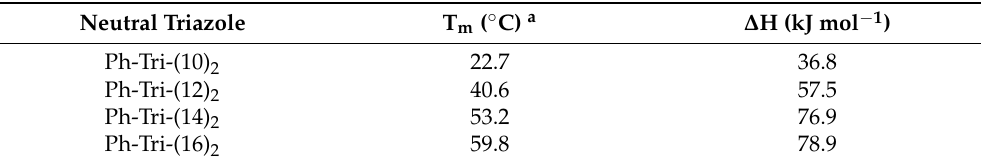
Table 1. Melting temperatures (T m ) and enthalpies ( ∆ H) of neutral triazole compounds obtained from the DSC traces upon heating.